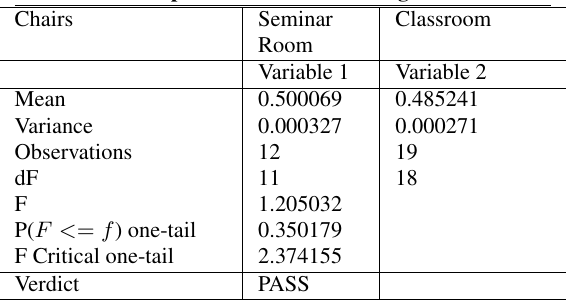
Table 6: Table showing the results of an F-Test performed in Microsoft R (cid:13) Office Excel 2013 5. F-TEST